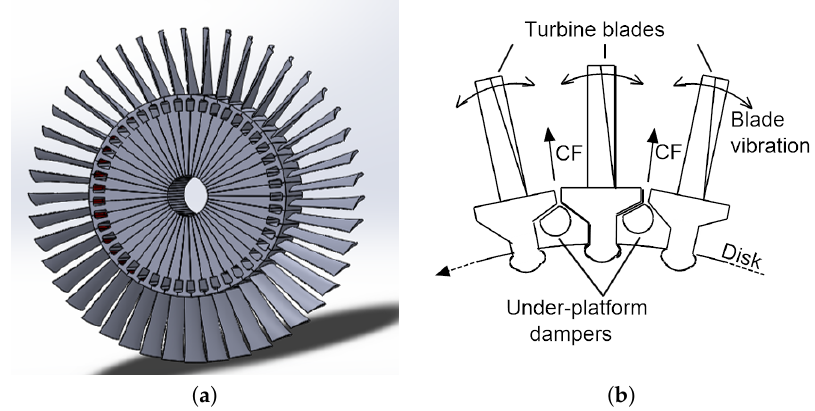
Figure 1. ( a ) CAD model of a turbine bladed disk with underplatform dampers (not directly visible in the figure). ( b ) Sketch representing a close up of three blades with interposed underplatform dampers.